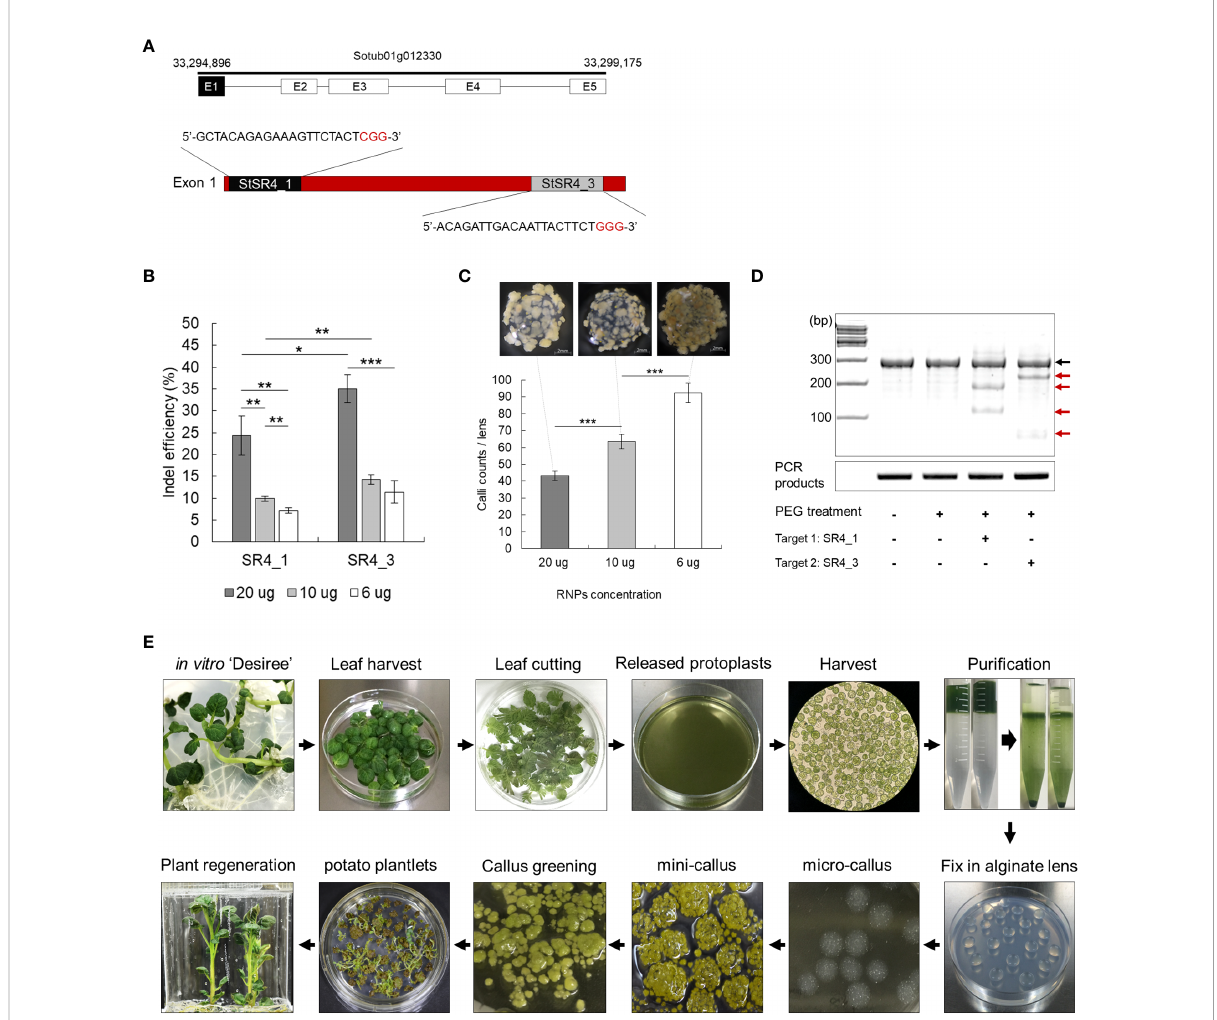
FIGURE 1 Ribonucleoprotein (RNP)-mediated CRISPR/Cas9 genome editing in potato. (A) Identi fi cation of target susceptibility ( S ) genes. Selection and design of two crRNA target sites in exon 1 of StSR4 in the potato cultivar Desiree. Black sequence, crRNA target sequence; red sequence, PAM site. (B) Indel ef fi ciency at two target sites, depending on the concentration of the Cas9 protein and guide RNA (gRNA) in protoplasts. Values represent the mean±SE of three replicated experiments. Student ’ s t-test; *p<0.05, **p<0.01, ***p<0.001. (C) Ef fi ciency of mini callus induction, depending on the concentration of RNPs in protoplasts. Callus growth as a function of RNP concentration: 20 µg, 10 µg, and 6 µg. (D) The T7E1 assay of mutations in protoplasts independently treated with SR4_1 and SR4_3 RNPs. Black arrow indicates the wild-type fragment; red arrow indicates indel-carrying fragments. (E) Schematic diagram showing the process of inducing plant regeneration from potato